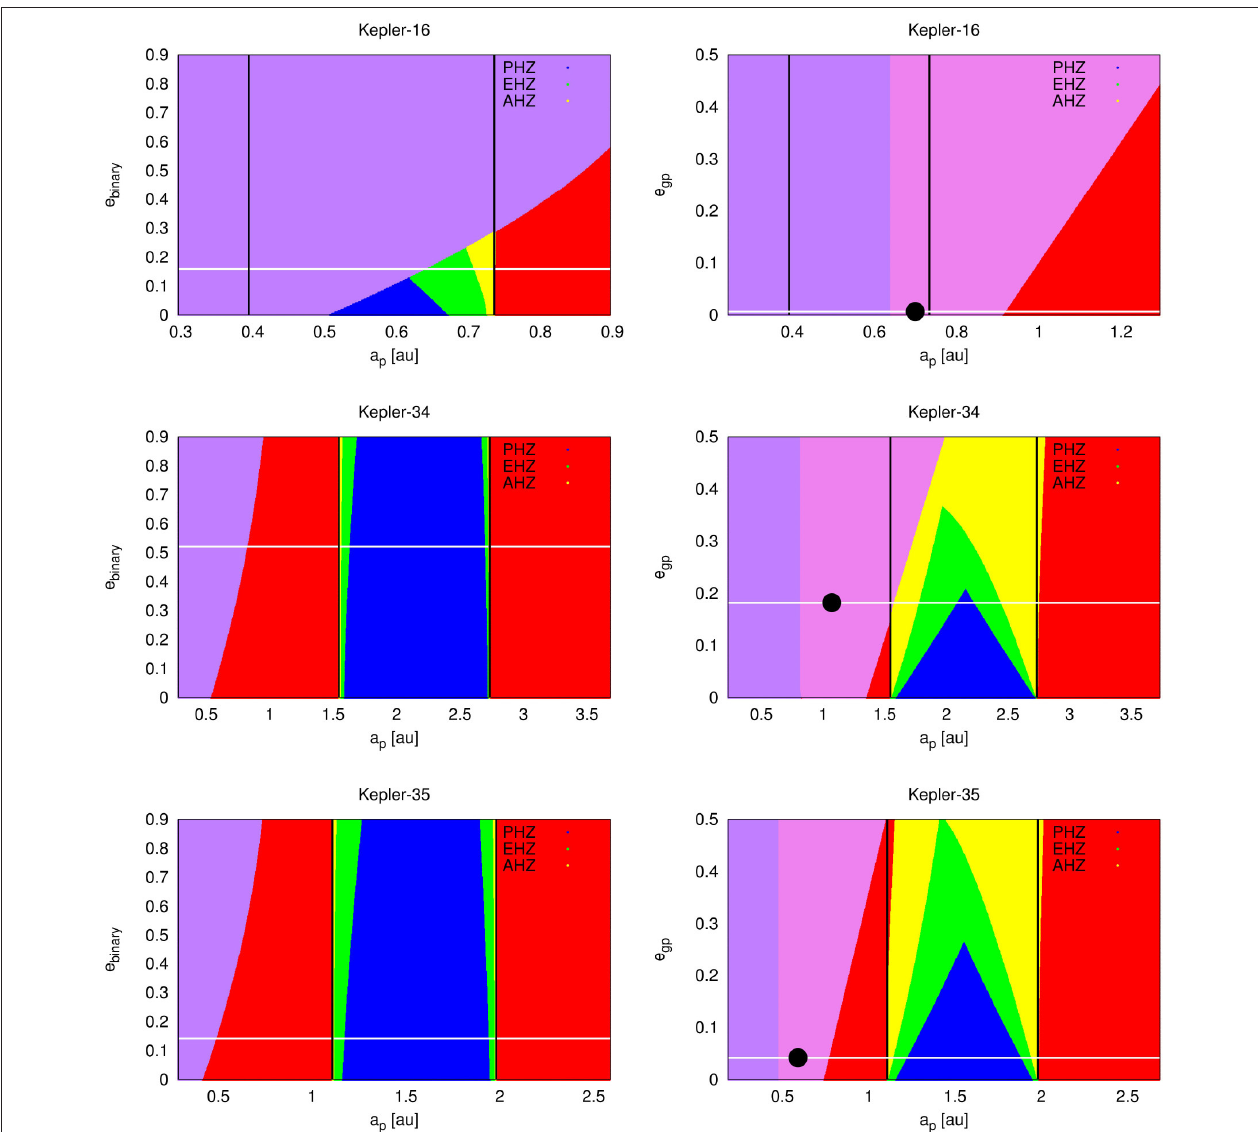
FIGURE 3 | Dynamically informed habitable zones for the Kepler-16, Kepler-34, and Kepler-35 systems. Plots in the left column show the different types of habitable zones without the presence of the known giant planets. The right column includes the influence of the known giant planets. Red colored regions correspond to uninhabitable areas, blue, green, yellow, and purple colors denote the PHZ, the EHZ, the AHZ, and unstable areas according to Holman and Wiegert (1999) stability criterion, respectively. Violet colored areas mark regions of dynamical instability caused by the giant planet in the system (Petrovich, 2015 dynamical stability criterion). The vertical black lines denote the classical habitable zone limits, while the horizontal white line in the left column plots marks the current eccentricity of the binary star orbit. In the right column graphs, the white line marks the current eccentricity of the giant planet orbit. Finally, the black dot in the right column plots shows the position of the giant planet in the presented parameter